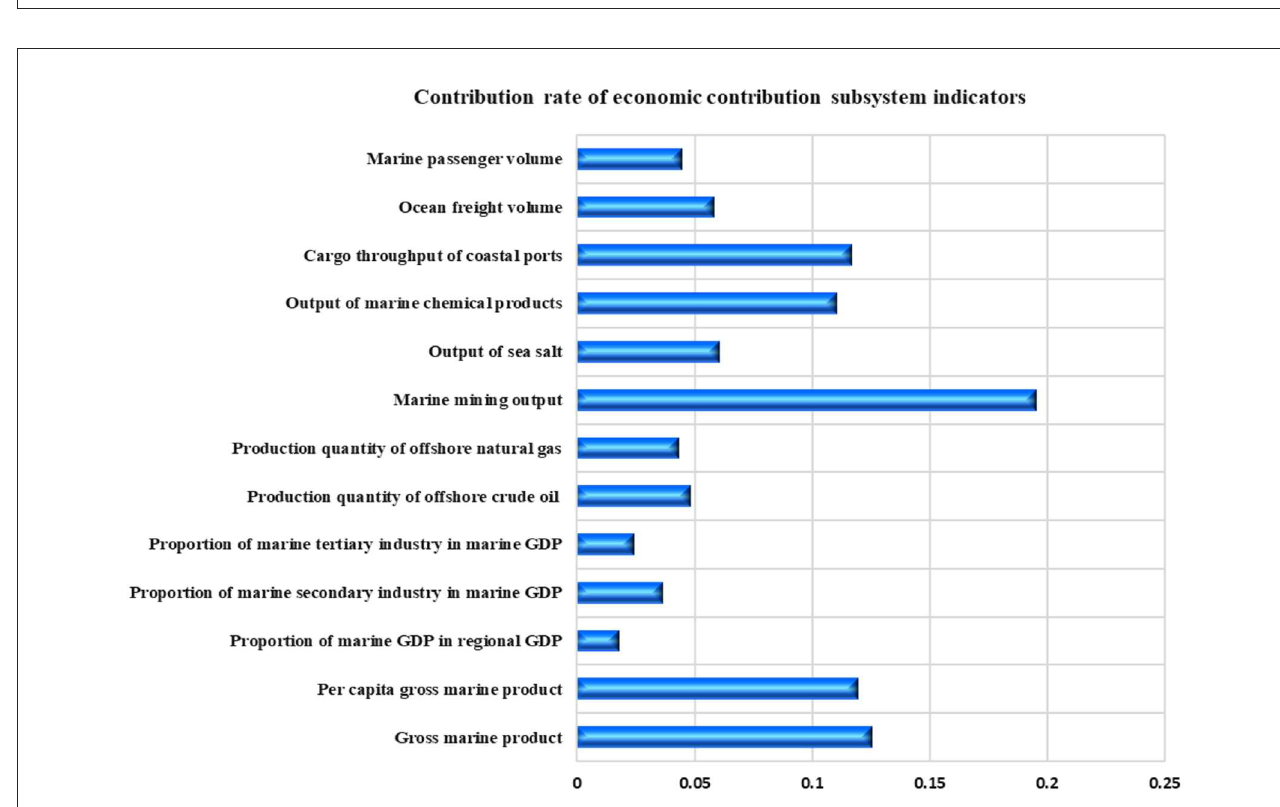
FIGURE5 Indicator contribution rate of coastal economic contribution subsystem in Shandong Province.